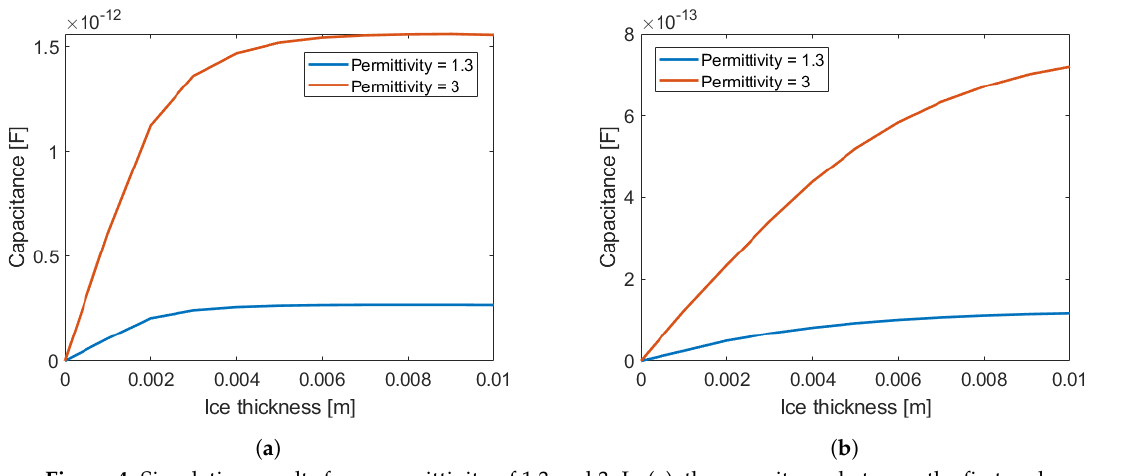
Figure 4. Simulation results for a permittivity of 1.3 and 3. In ( a ), the capacitance between the first and second electrode in differential measurement mode is shown, while in ( b ) we have the capacitance between the first and third